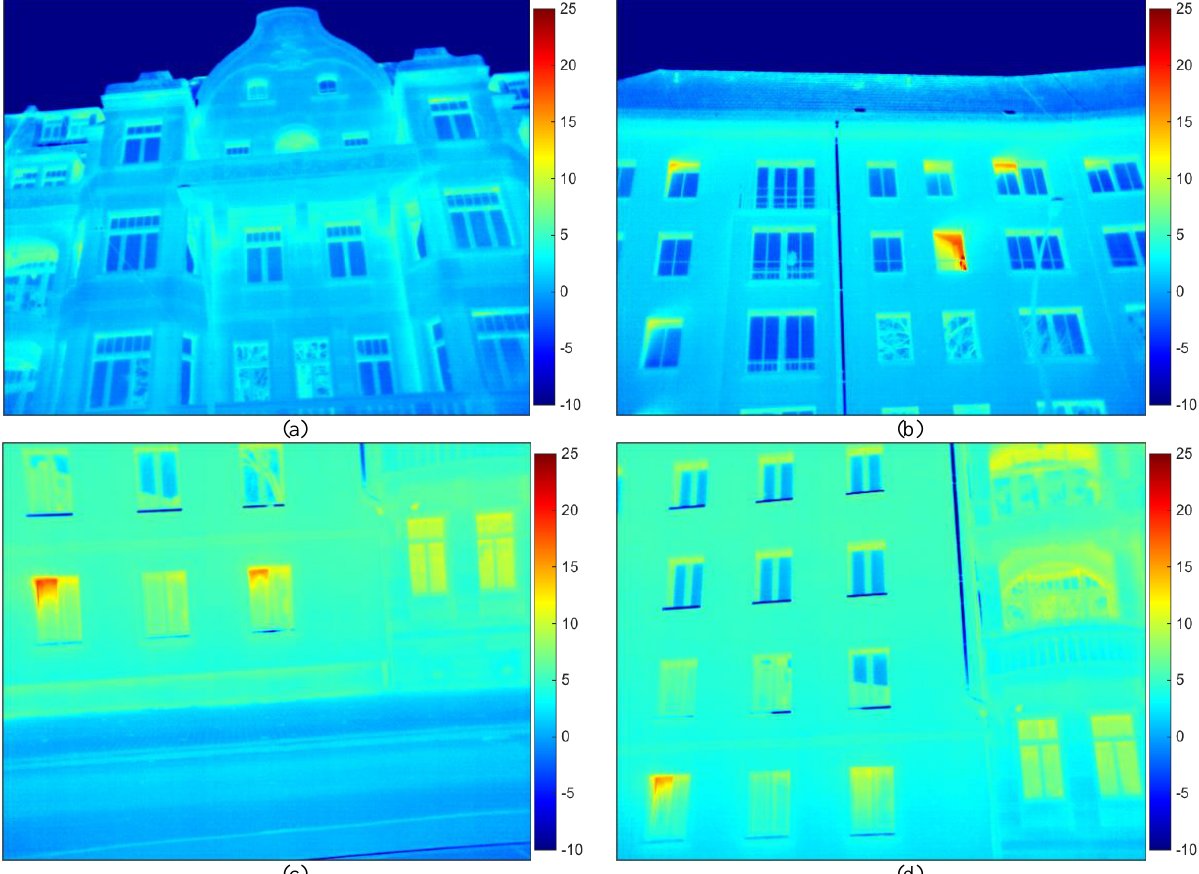
Figure 1. Four exemplary radiant temperature images ( °C) after radiometric